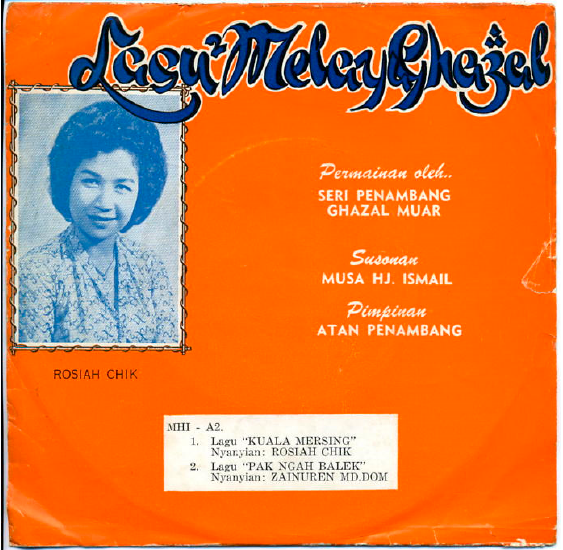
Figure 5. Cover of Rosiah Chik’s Lagu2 Malayu Ghazal , 7-inch 45rpm gramophone